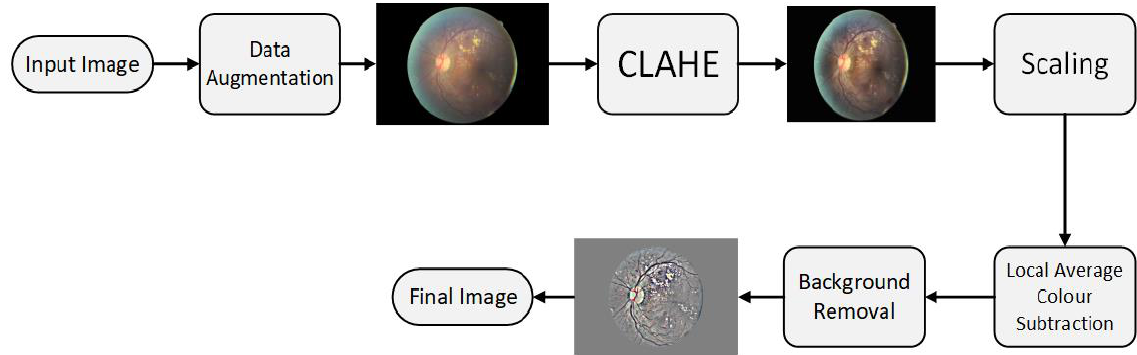
Figure 2. Pre-processing phase of input